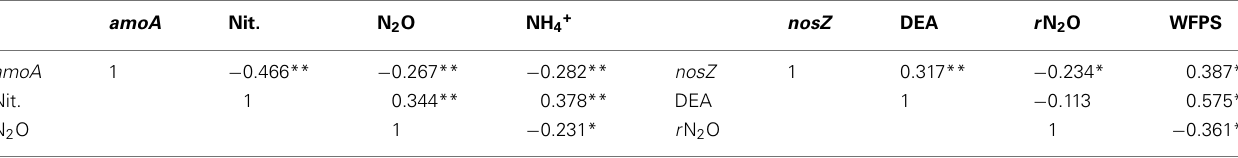
Table 1 | Correlations between amoA and nosZ abundance with 15 N-N 2 O produced from nitrification and denitrification enzyme assay and water-filled pore space,